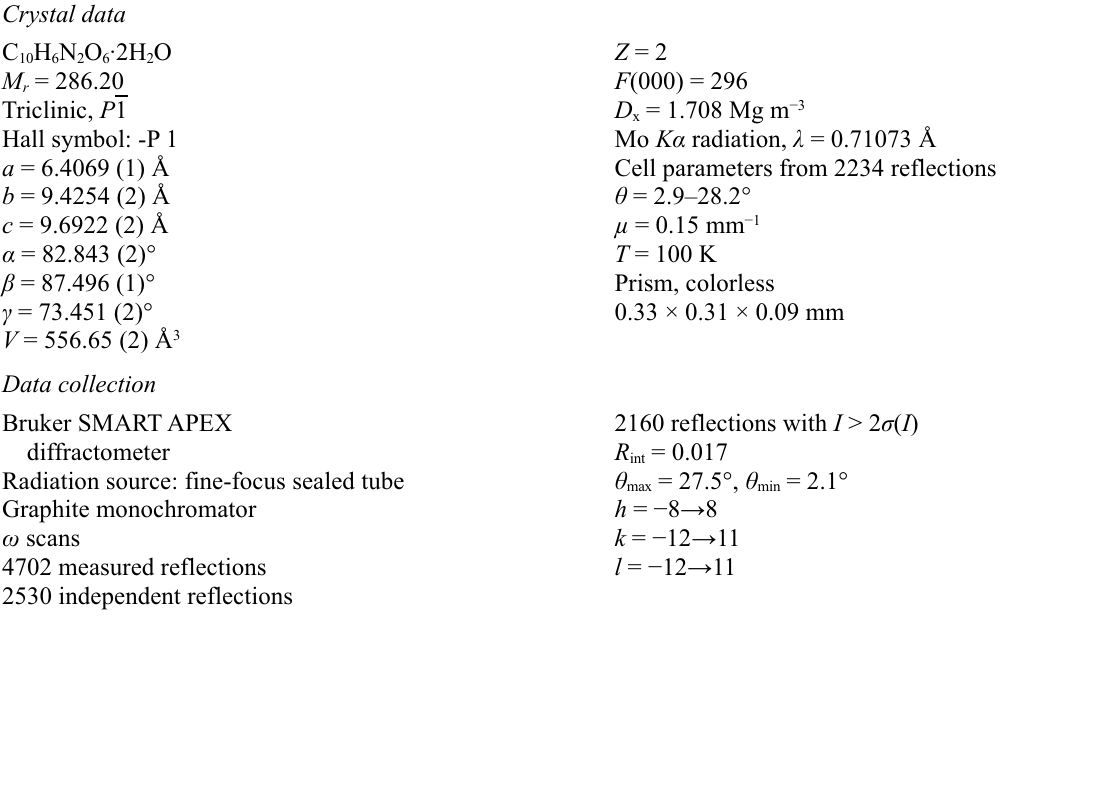
Figure 1 Molecular structure of (I) showing atomic labelling scheme and displacement ellipsoids at the 70% probability level. 4-Hydroxy-1-oxo-1,2-dihydrophthalazine-6,7-dicarboxylic acid dihydrate Crystal